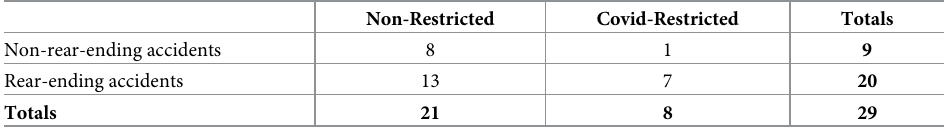
Table 4. Waymo accident types during “Non-Restricted” vs “Covid-Restricted” periods.